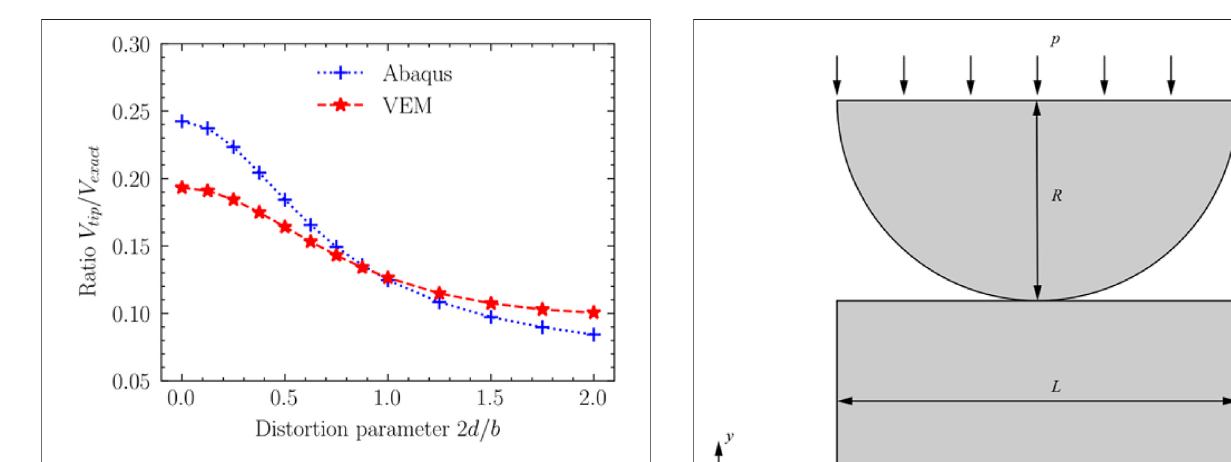
FIGURE 4 | Curve of the ratio of calculated value to real value with twist parameter.